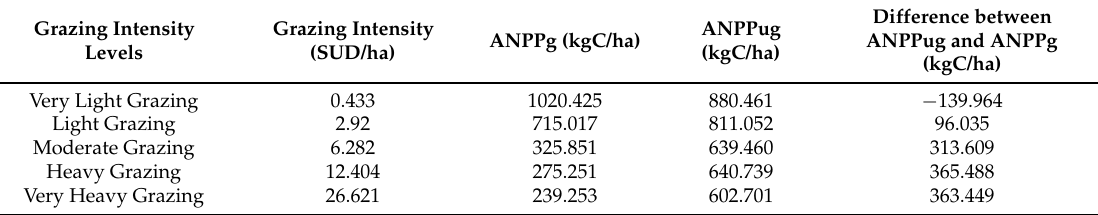
Table 5. The regional average grazing intensity, the regional average ANPP considering grazing (ANPPg) and without considering grazing (ANPPug) for different grazing intensity levels in Zoige